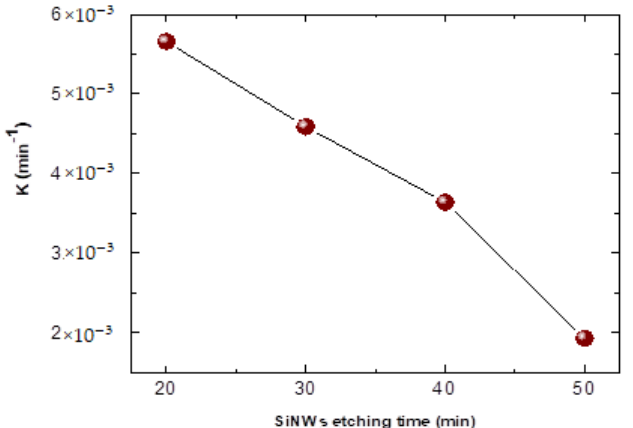
Figure 14. Kinetics curve of PbS/SiNWs sample for 20, 30, 40, and 50 min SiNWs etching time for- mation .